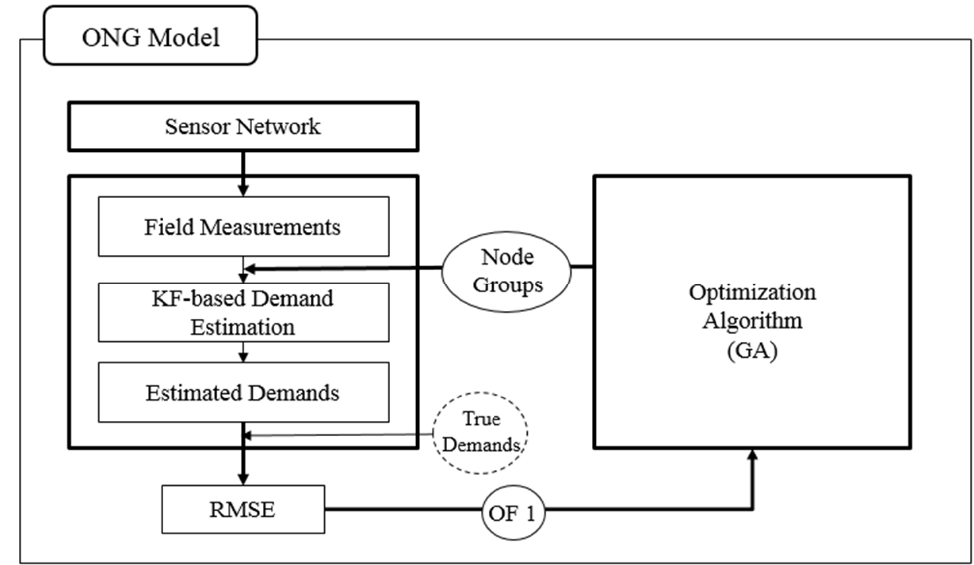
Figure 2. Structure of the proposed optimal node grouping (ONG) model. OF indicates objective function.